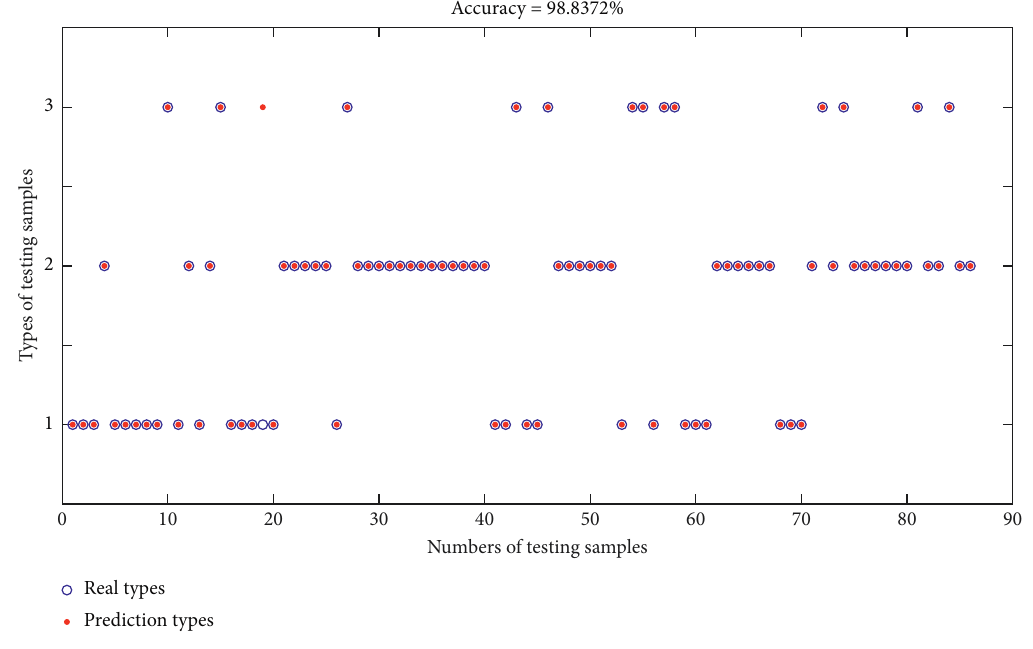
Figure 3: Prediction results of testing samples by SVM classification models of Nos. 21 to 29.